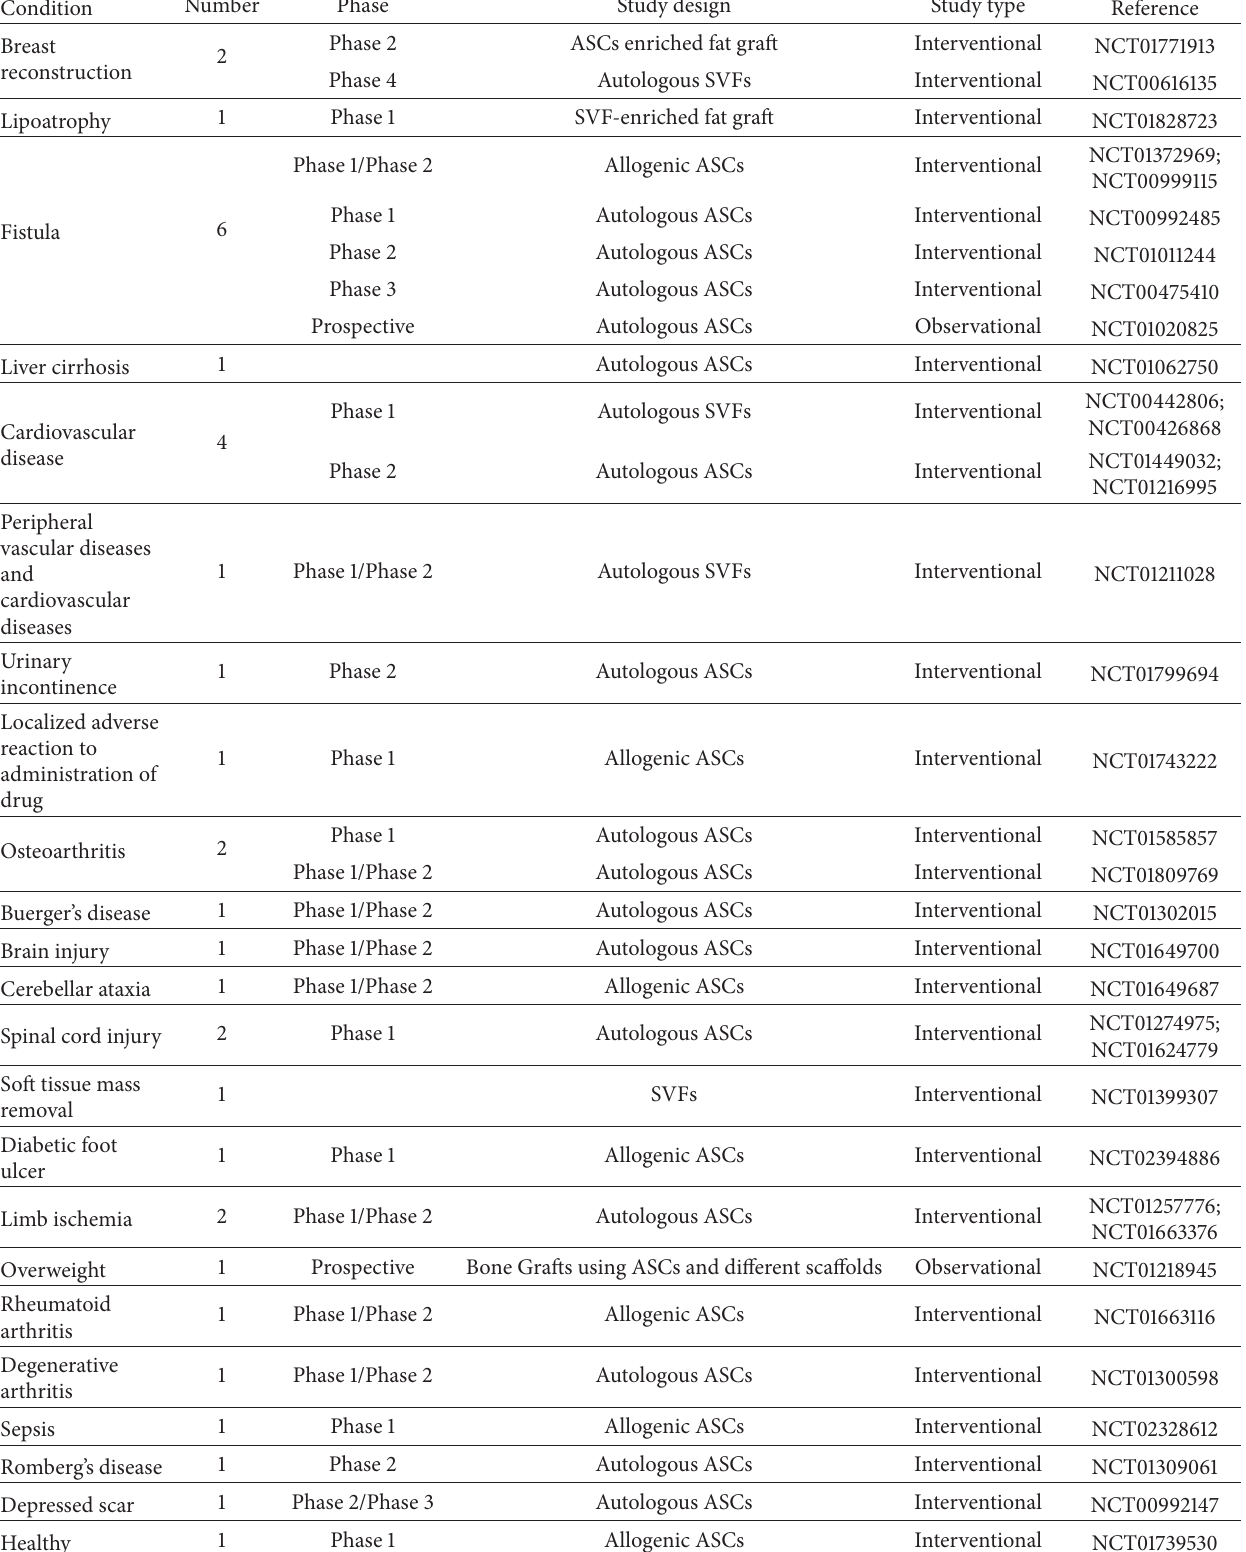
Table 5: List of clinical trials using